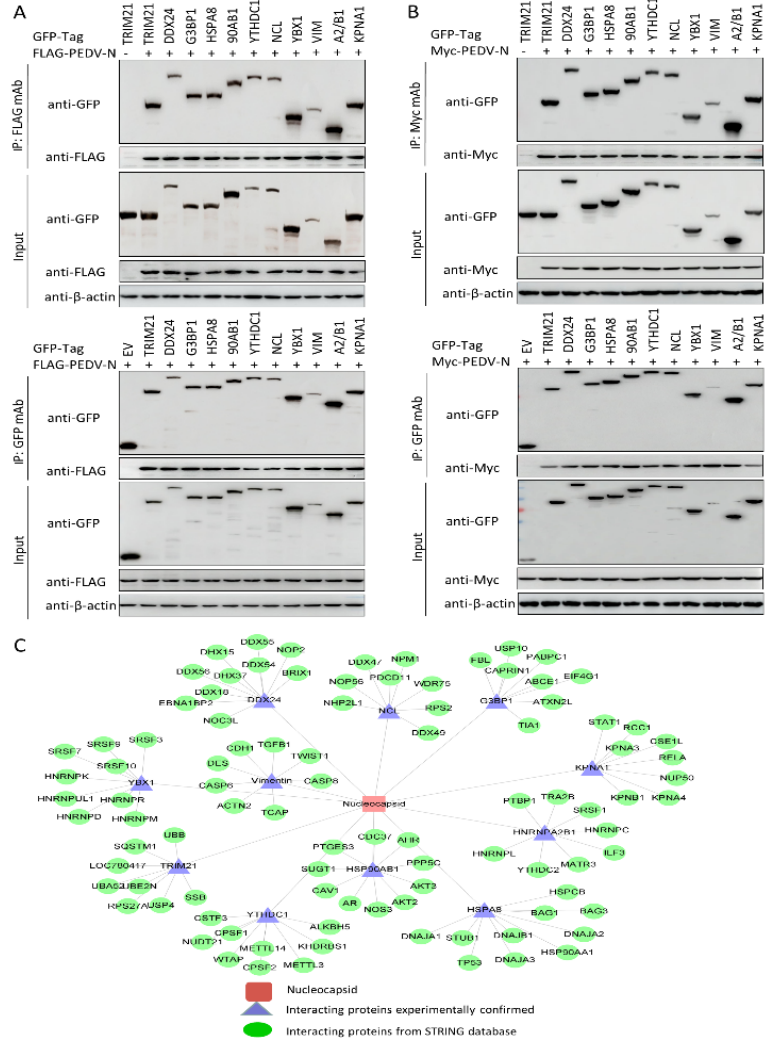
Figure 5. Validation of PEDV N–host protein interactions. ( A , B ) HEK293T cells were co-transfected with plasmids expressing either GFP-TRIM21, GFP-DDX24, GFP-G3BP1, GFP-HSPA8, GFP-HSP90AB1, GFP-YTHDC1, GFP-NCL, GFP-YBX1, GFP-vimentin, GFP-hnRNPA2/B1, or GFP- KPNA1 and plasmids expressing FLAG-PEDV-N ( A ), or Myc-PEDV-N ( B ). Among them, FLAG- PEDV-N ( A ), Myc-PEDV-N ( B ), and GFP-TRIM21 ( A , B ) were all co-transfected with an empty vector serving as the negative controls, while FLAG-PEDV-N ( A ), or Myc-PEDV-N ( B ) co-transfected with GFP-TRIM21 ( A , B ) served as positive controls. Cell lysates were immunoprecipitated with FLAG beads, or anti-GFP mAbs, or anti-Myc mAbs and then separated via SDS-PAGE. Western blotting was then performed with the corresponding primary and secondary antibodies. β -actin served as the internal loading control. ( C ) The PEDV N–host interaction network. The interaction map of PEDV N and the corresponding host proteins was constructed using Cytoscape. Proteins were classified based on their protein class. The corresponding symbols indicating different protein classes are mentioned in the Supplementary Table S5.